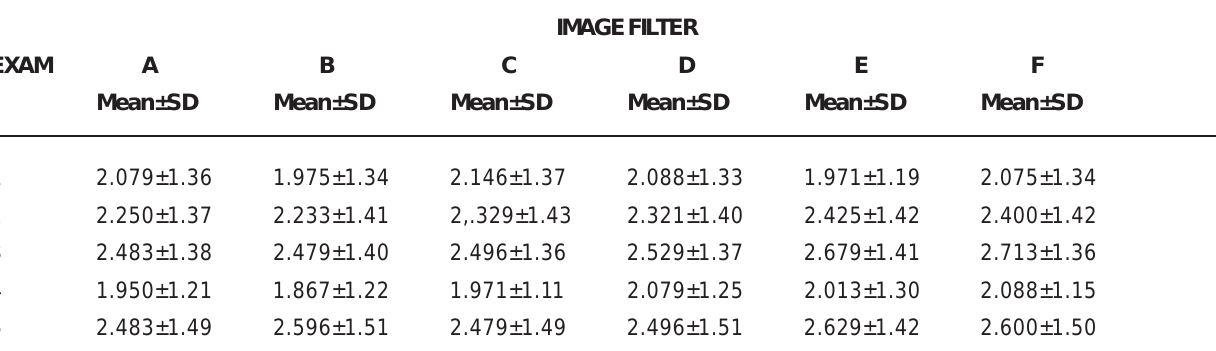
TABLE 1- Mean and standard deviation (SD) for the values of each examiner using different image